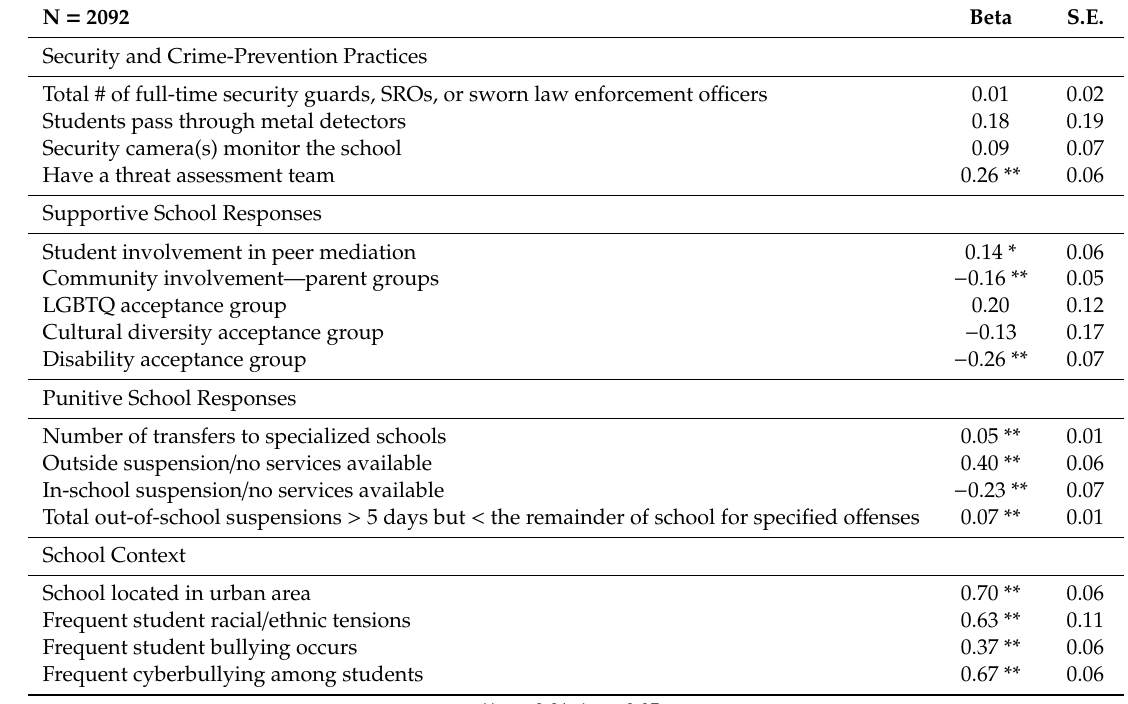
Table 3. Negative binomial regression results for number of disciplinary